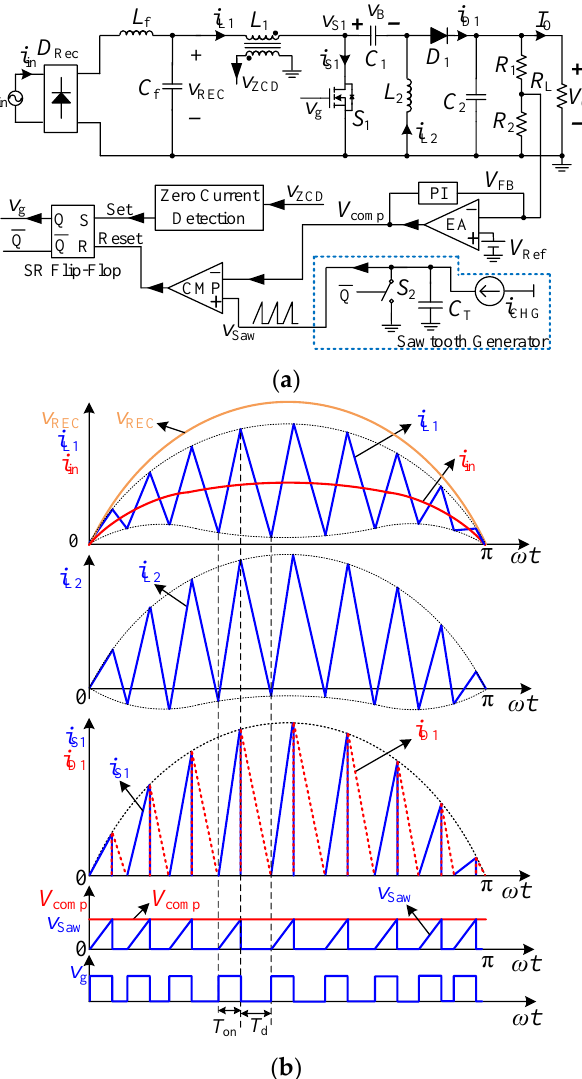
Figure 2. Block diagram and main waveforms of SEPIC PFC converter operating in BCM with the traditional COT control scheme. ( a ) Block diagram; ( b ) Key waveforms during half AC line period.